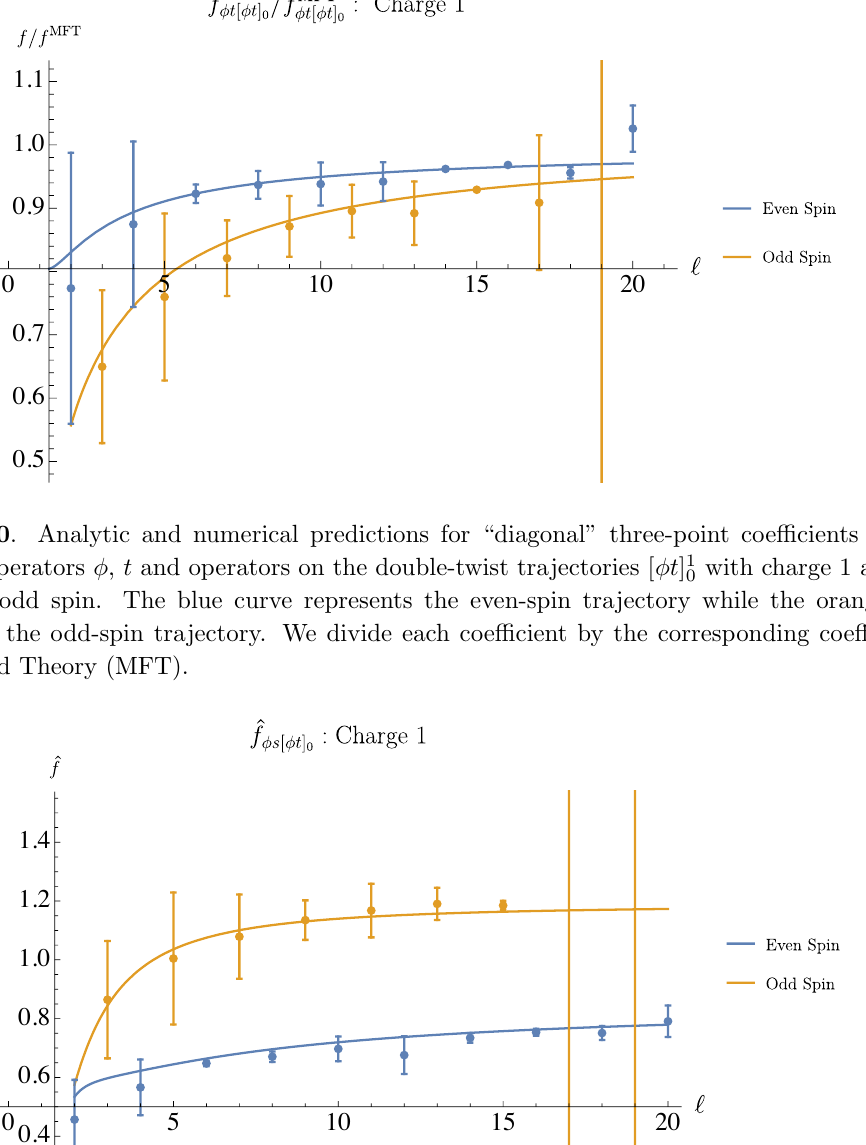
Figure 11 . Analytic and numerical predictions for \o(cid:11)-diagonal" three-point coe(cid:14)cients between external operators (cid:30) , s and operators on the double-twist trajectories [ (cid:30)t ] 1 both even and odd spin. The blue curve represents the even-spin trajectory while the orange curve represents the odd-spin trajectory. We normalize the OPEs such that the asymptotic values are one. the spectrum. Taking these errors into account, we see the analytic curve is consistent with the prediction from the extremal